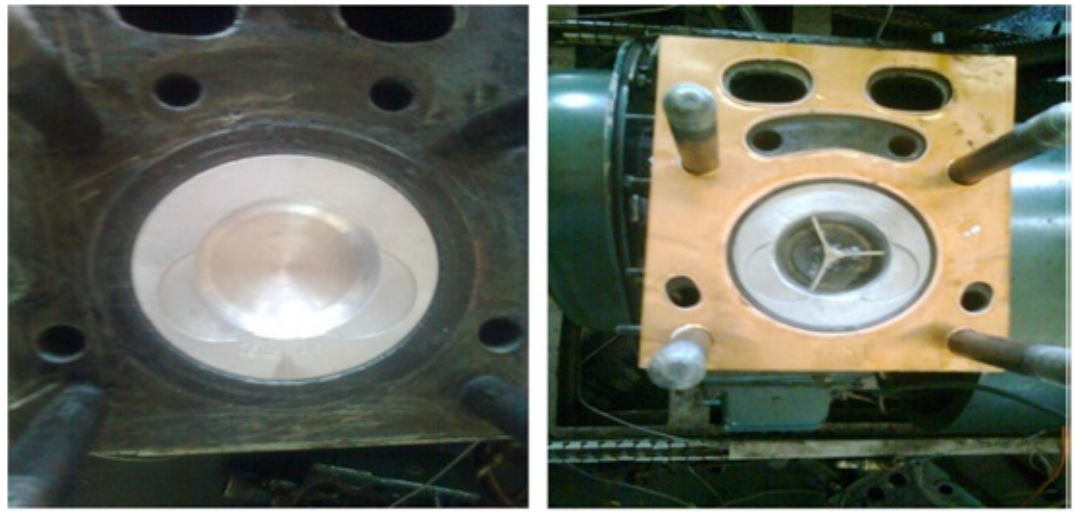
Figure 4. ( a ). Standard piston [23]. ( b ). Modified piston [23].